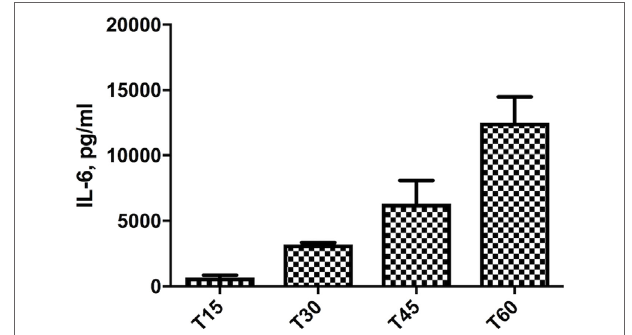
FigUre 1 | Increase of IL-6 levels in THP-1 cells, differentiated in macrophages by phorbol myristate acetate treatment, cultured for different times. T15–T60 refer to days after the cell batch had been